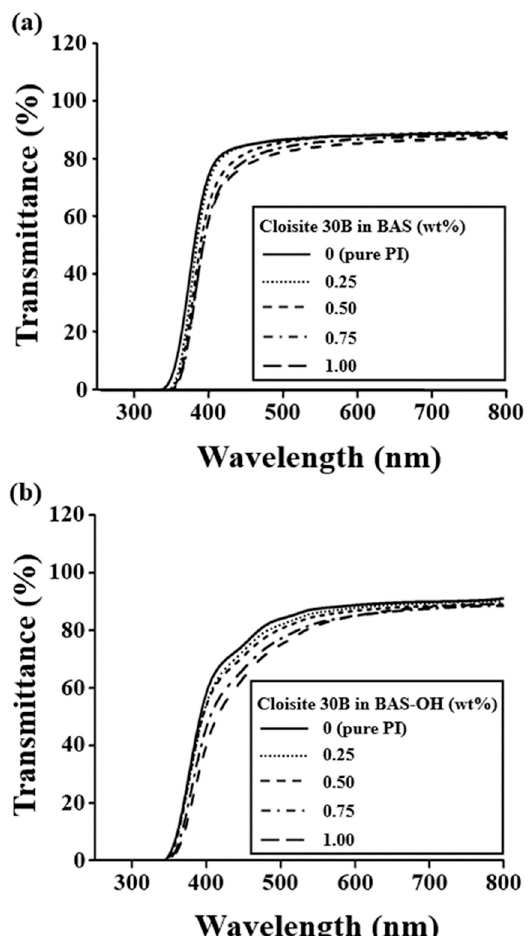
Figure 10. UV-Vis transmittance of the PI hybrid films with various organoclay contents: ( a ) BAS and ( b ) BAS-OH. Table 4. Optical transparencies of PI hybrid films with various organoclay contents. Cloisite